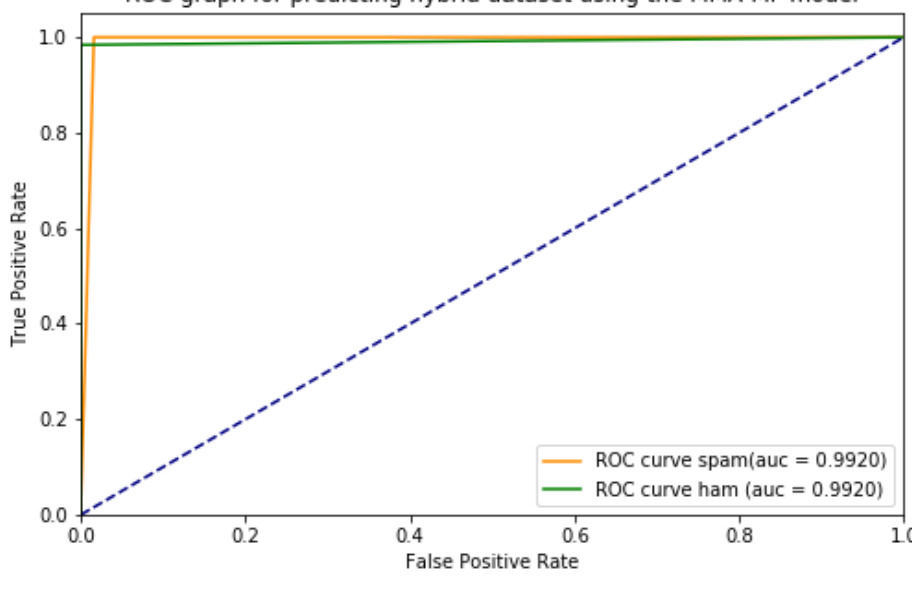
Figure 6. ROC chart for Hybrid Dataset 1.